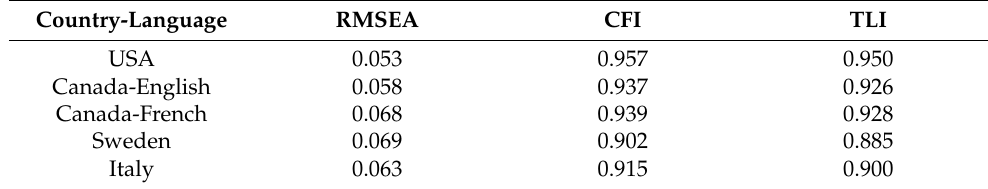
Table 2. Three factor model goodness-of-fit measures by country-language. Country-Language